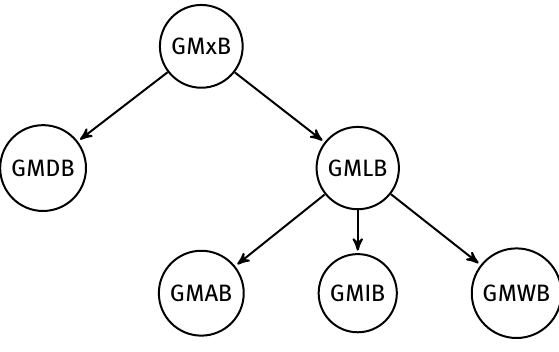
Figure 1: Some common guarantees provided by variable